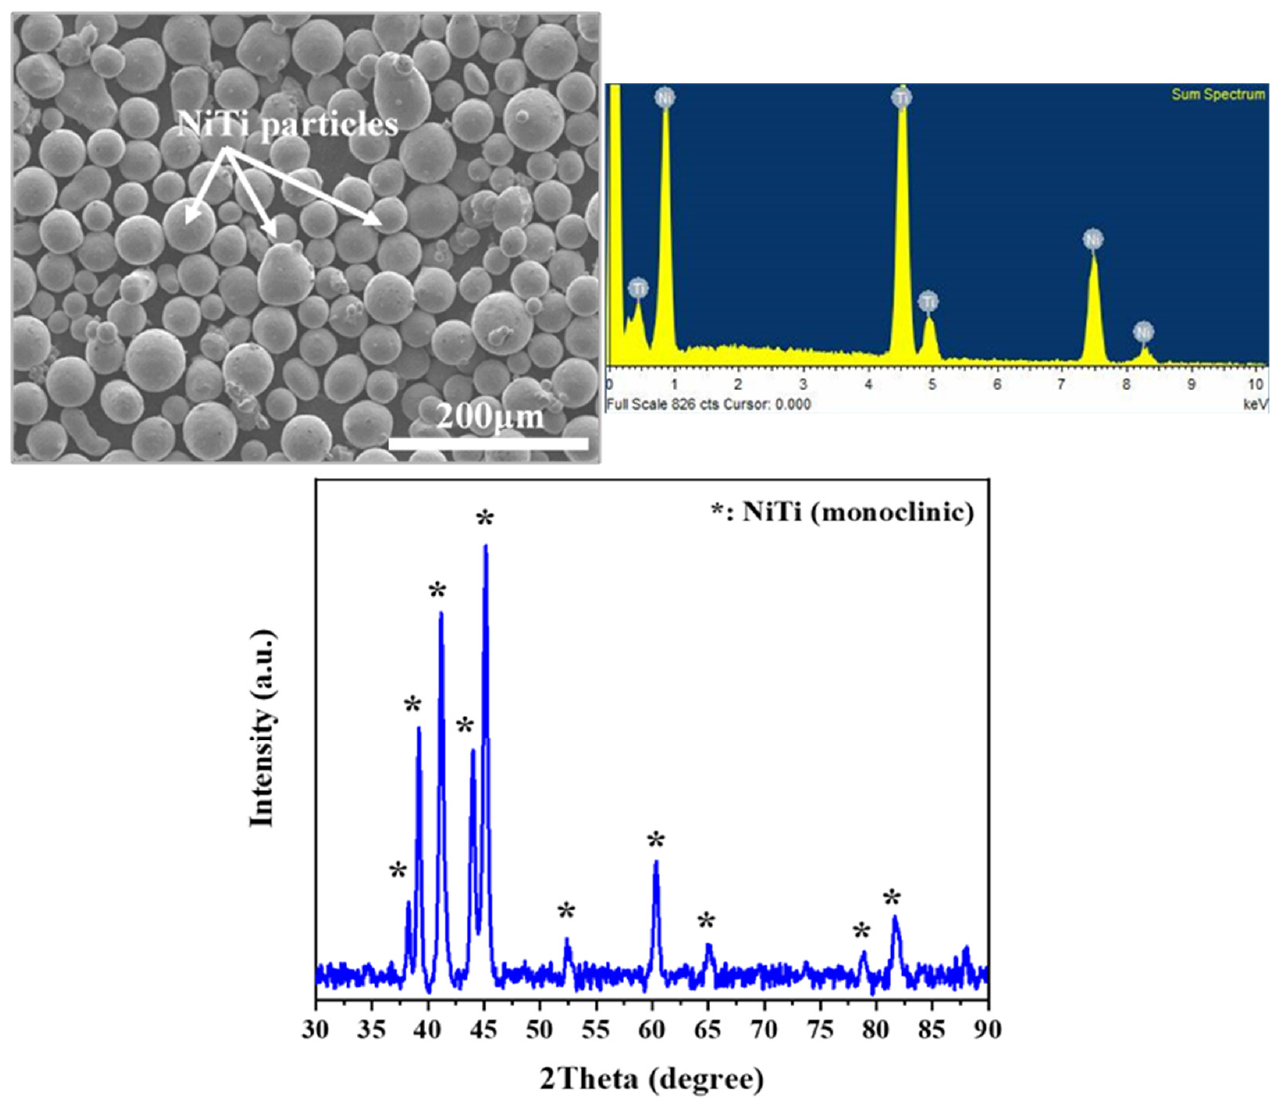
Figure 1. Electron micrograph showing NiTi powder, sum spectrum depicting the presence of nickel and titanium as constituents of the powder, and x-ray diffraction plot of NiTi powder depicting monoclinic intermetallic NiTi phase peaks denoted by *.